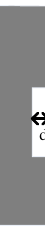
Figure 4: IDs and IAs of poly fractal boundary